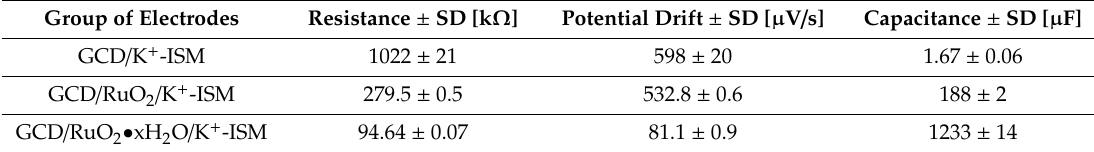
Table 2. Electrical parameters of studied electrodes (n = 3). GCD: glassy carbon